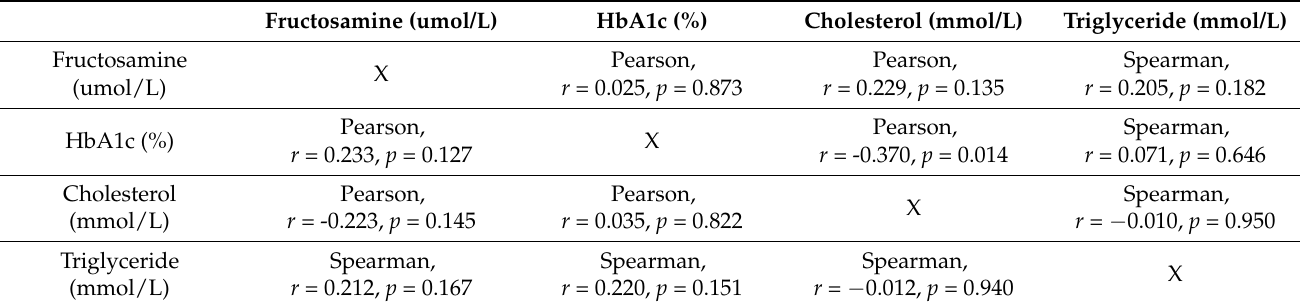
Table A2. Correlations between different biochemical parameters in adult female long-tailed macaques ( n = 44). The type of correlation, correlation coefficient ( r ), and significance ( p ) are reported 1 .